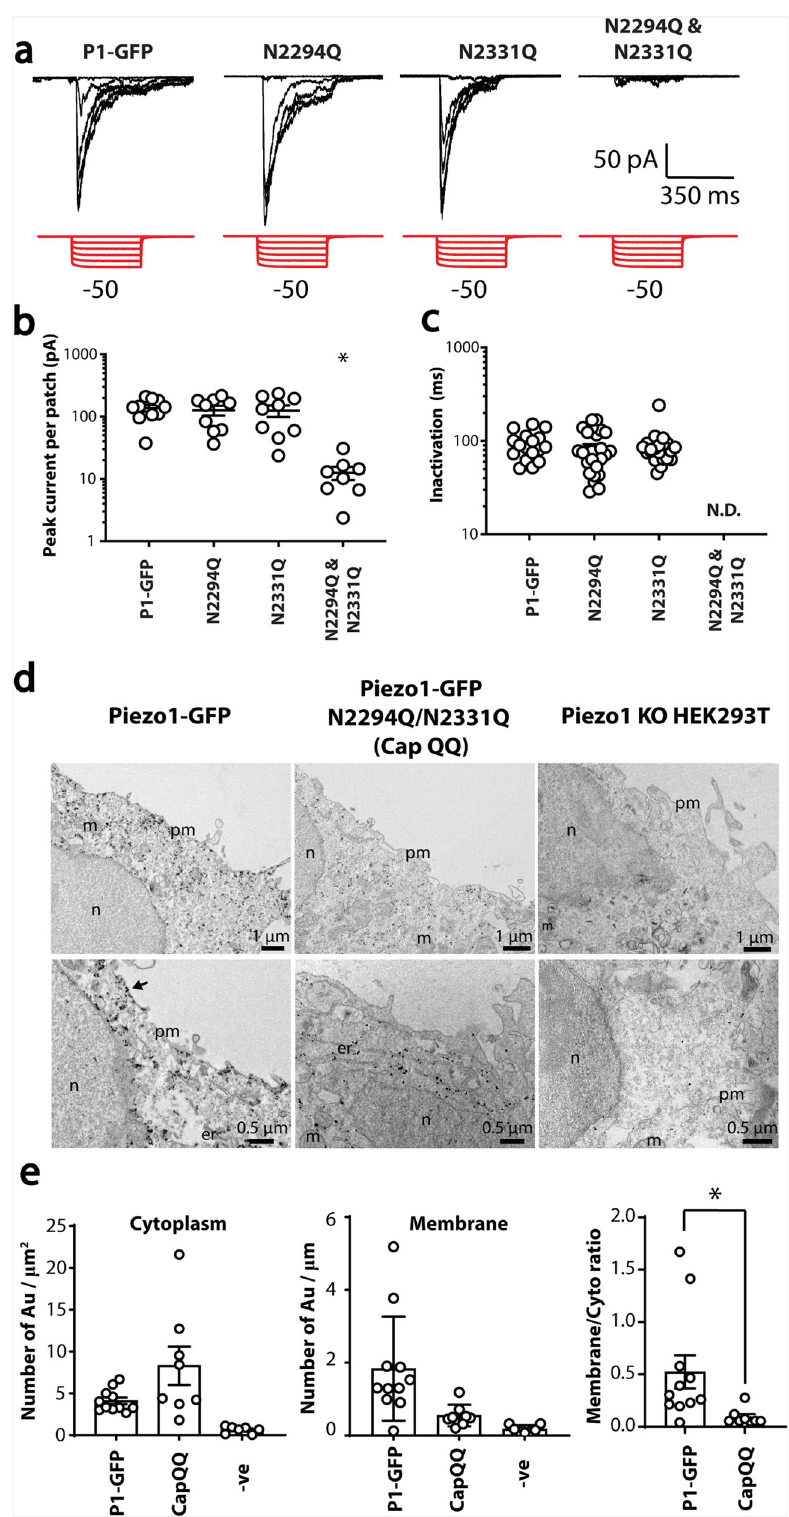
Piezo1 protein represented the membrane protein pool (Figs. 2e, f and